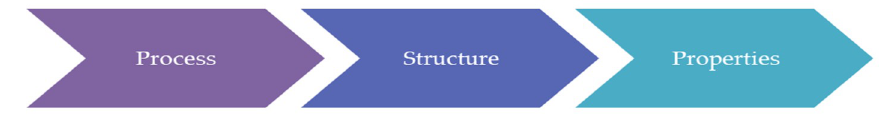
Figure 5. Process–structure–property (PSP) information flow.